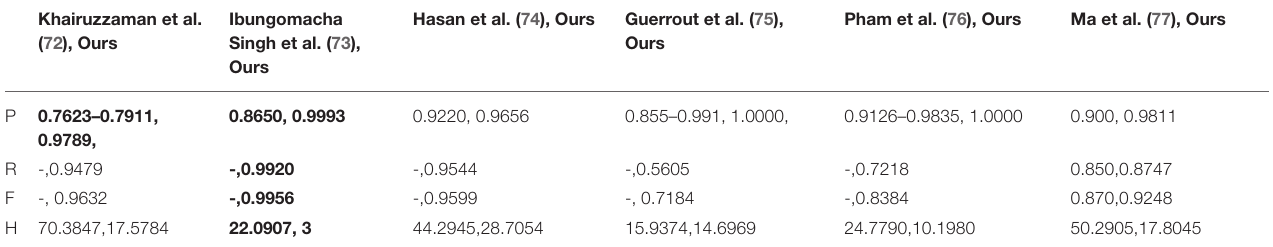
TABLE 7 | Evaluate parameters in test 3-part